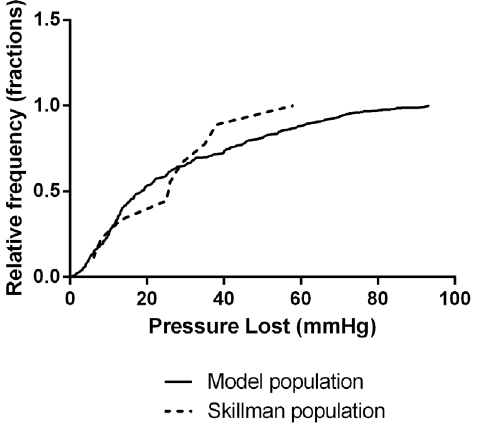
Figure 2. Survival function of the pressure loss experienced by individual models compared with Skillman’s data [ 5 ] ; the results are similar (p , 0.05). The vertical axis denotes the percentage of individuals who lost MAP less than the x-input.